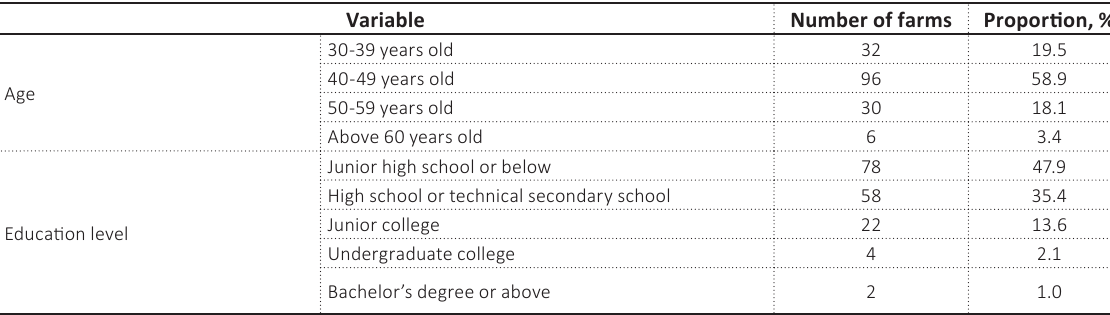
Table 2. Statistical analysis of variables Variable Number of